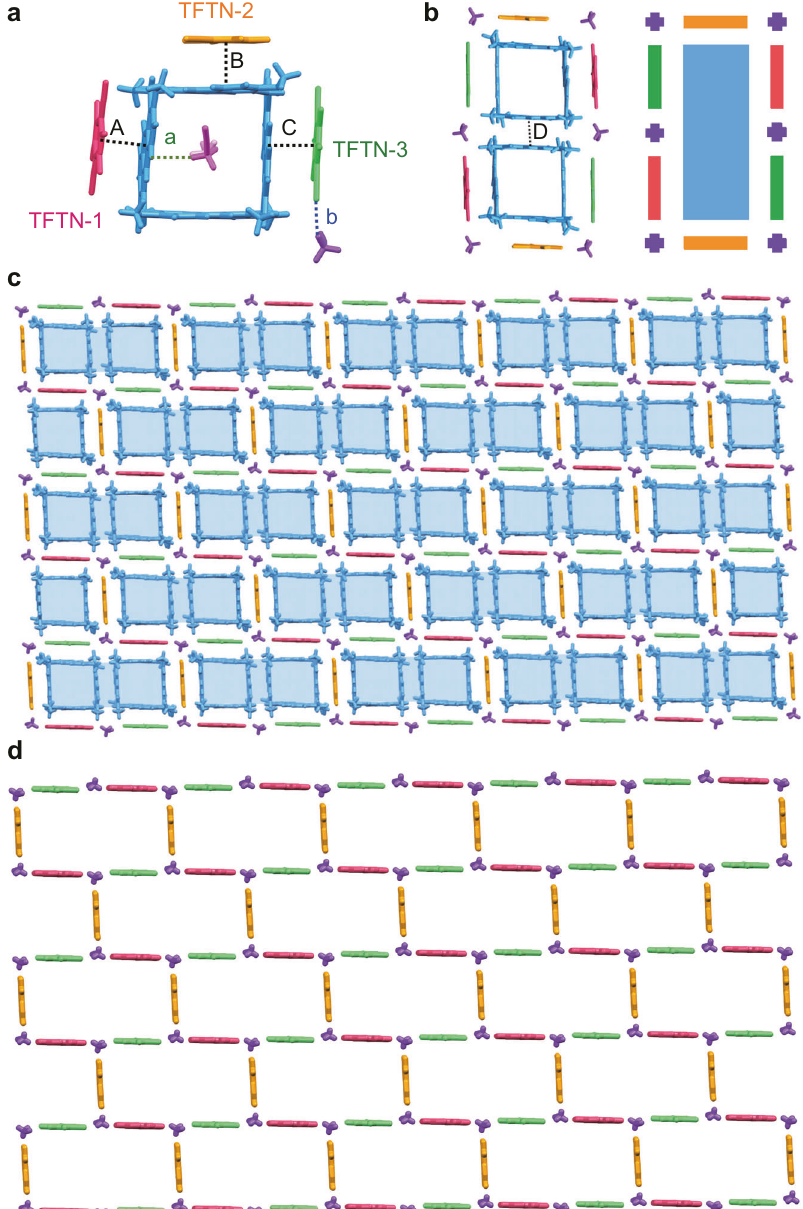
Fig. 9 Supramolecular tessellations of P4 with TFTN in acetonitrile system. Crystal structure of P4-TFTN c showing a the asymmetric unit; b the basic tiling unit formed by two P4, six TFTN molecules around and six CH 3 CN molecules as vertexes and its schematic representation; c two-dimensional layer- like network superstructure; d regular brick-like grids formed by TFTN molecules. Different colors represent the symmetry equivalence and solvent molecules are omitted for clarity. Crystallographically independent TFTN molecules were marked as TFTN-1, TFTN-2, and TFTN-3,